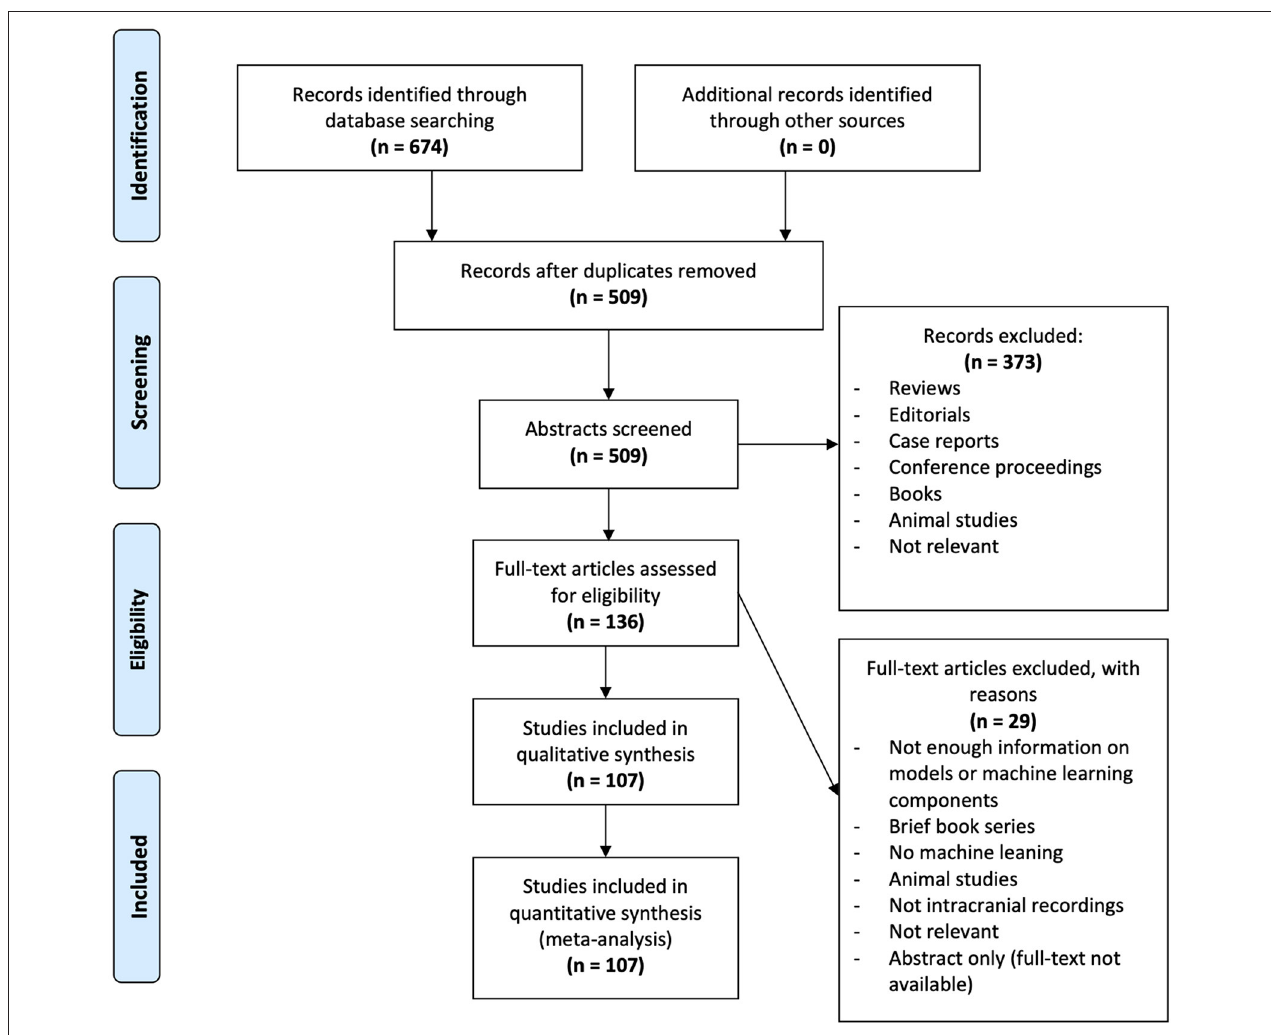
FIGURE 2 | PRISMA analysis of articles searched, filtered and included in the systematic review. Six-hundred-seventy-four articles were identified through database searching in OVID MEDLINE, IEEE, and Web of Science. Duplicates were removed leaving 509 abstracts for screening. Three-hundred-seventy-three articles were excluded as they did not fit out inclusion criteria. From the remaining 136 articles, 29 were excluded following full-text screening. The remaining 107 articles were analyzed in this